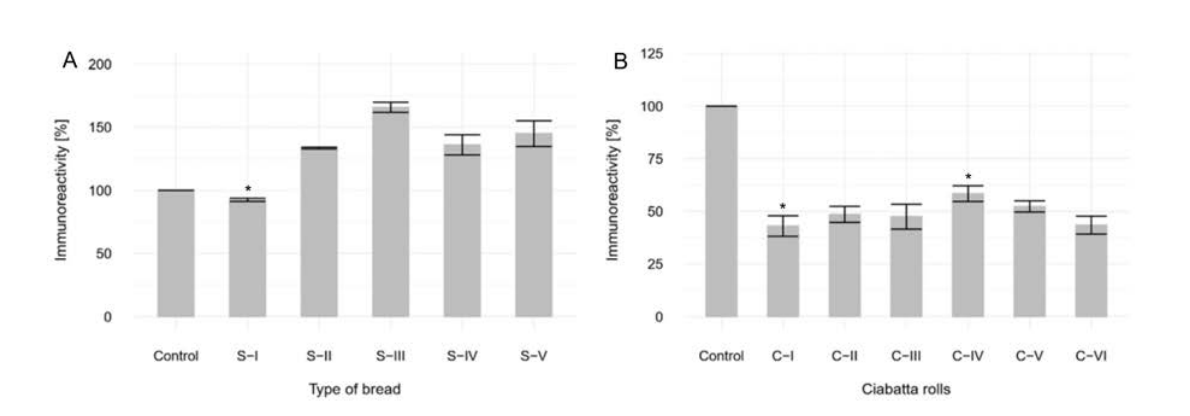
Figure 3. ( A ). Change in immunoreactivity of wheat flour proteins for di ff erent types of sourdough bread relative to yeast bread. Samples marked with * are statistical significance at the p < 0.05 level. ( B ). Change in immunoreactivity of wheat flour proteins for di ff erent types of ciabatta rolls relative to yeast bread. Samples marked with * are statistical significance at the p < 0.05